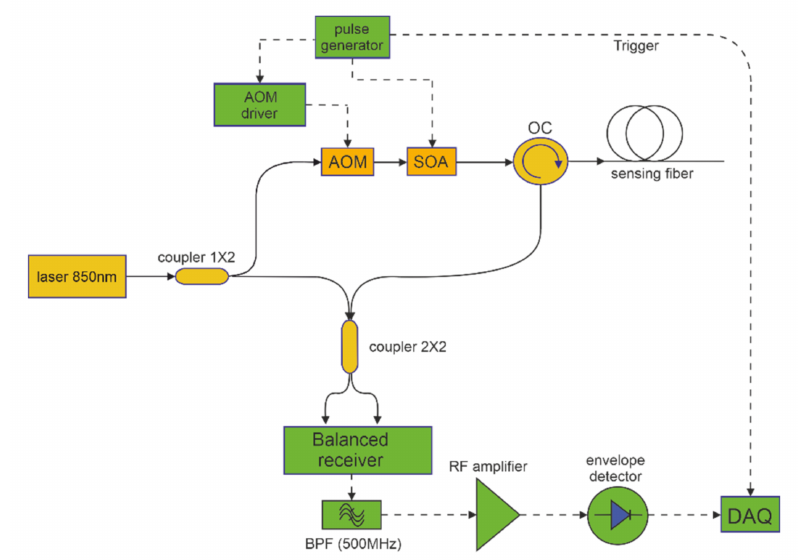
Figure 1. Experimental setup for φ -OTDR measurements at 850 nm. AOM: acousto-optic modulator; SOA: semiconductor optical amplifier; OC: optical circulator; BPF: bandpass filter; DAQ: data acquisition